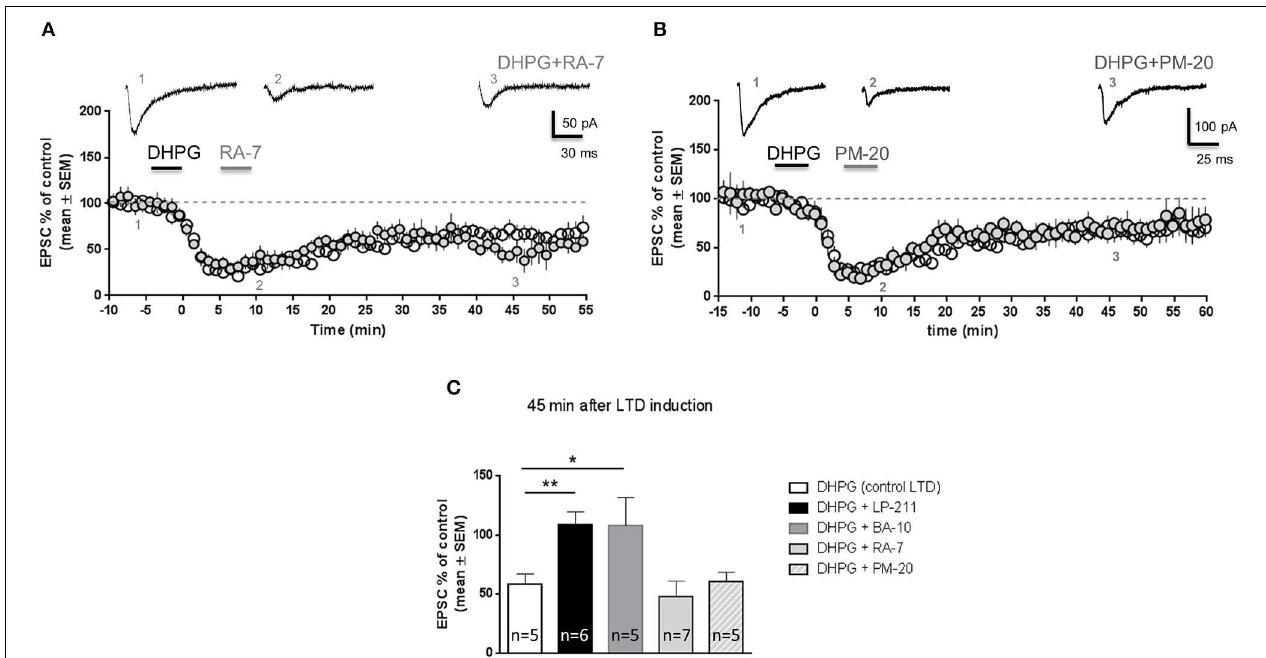
FIGURE 4 | RA-7 and PM-20 did not reverse mGluR-LTD in the hippocampus of wild-type mice. Hippocampal slices (300 µ m) were prepared from wild-type mice (FVB; PN 14-21). Pooled data of % EPSC values (mean ± SEM) were plotted vs time; insets show individual EPSC traces from representative experiments. When DHPG application was followed by application of RA-7 ( A; 10nM, 5min) or PM-20 ( B; 10nM, 5min), mGluR-LTD was not reversed. (C) Histograms show mean EPSC amplitude (% of control) 45min after DHPG